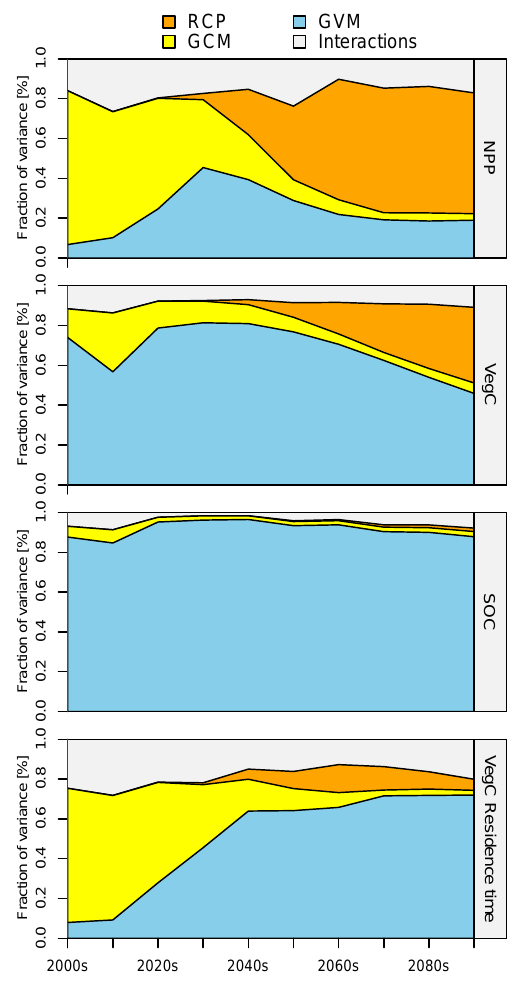
Figure 2. Fraction of variance derived from the emission scenar- ios (RCPs), GCMs, and GVMs for annual NPP, VegC, SOC, and VegC residence time changes. The variances were estimated by three-way ANOVA. The fractions in interactions include the sum of variations of interaction terms (RCP × GCM, RCP × GVM, and GCM ×